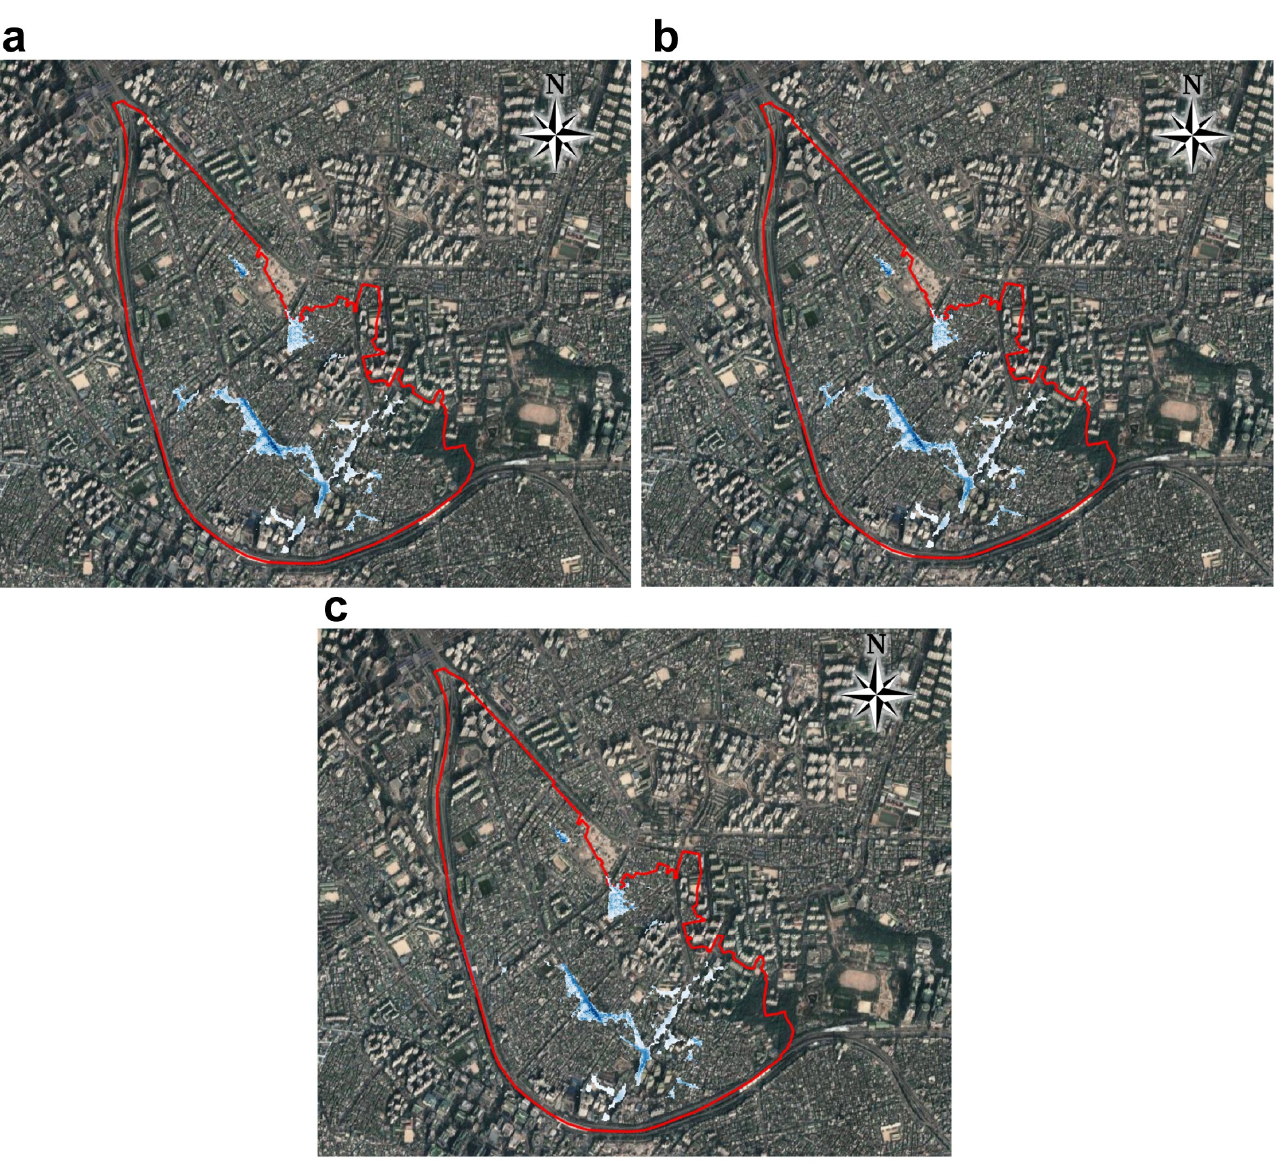
Figure 14. Flood analysis in the Dorim watershed according to the reduction facility installation conditions. ( a ) Not installed, ( b ) installation of the underground storage tank, and ( c ) installation of the trunk drainage sewer.